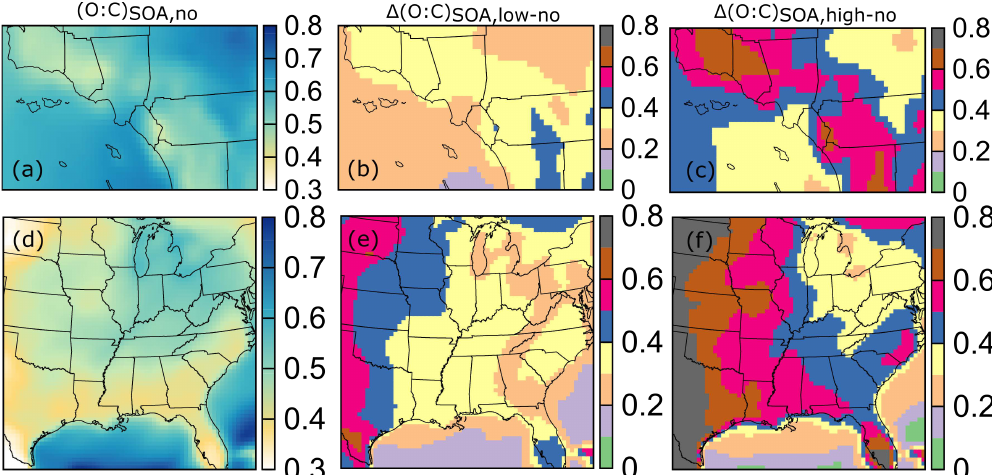
Figure 6. 14-day averaged O:C atomic ratios for SOA for (a) SoCAB and (d) the eastern US for the SOM-no simulations. The difference in O:C between the SOM-low or SOM-high and SOM-no simulations, termed (cid:49) (O:C), is shown in panels (b–c) for SoCAB and (e–f) for the eastern